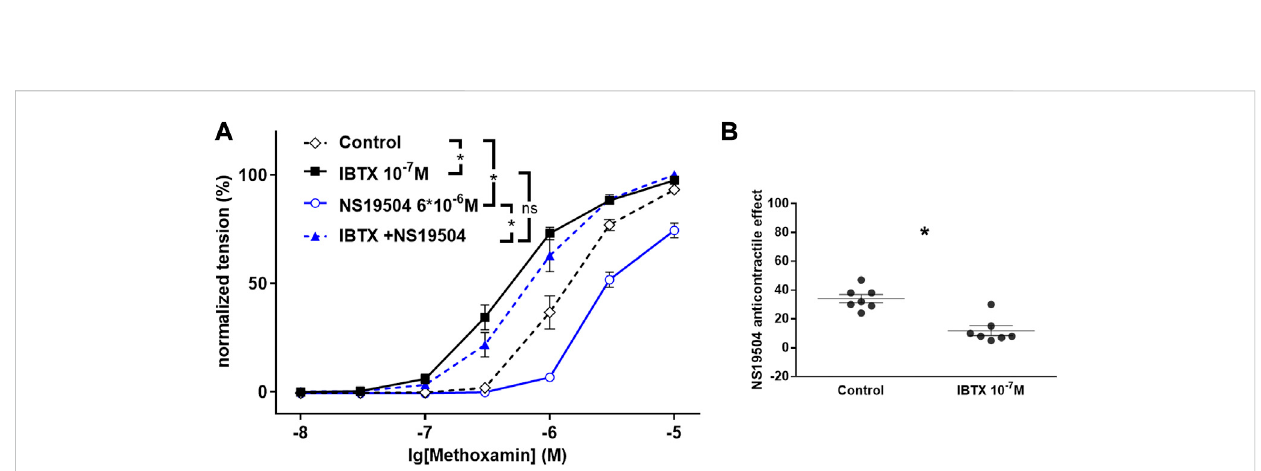
FIGURE 2 Effect of NS19504 and IBTX on methoxamine-induced contractions of the rat A. saphena. (A) Normalized tension (normalized to the maximum responseofthe1stCRR-seeFigure1)ofA.SaphenaatdifferentmethoxamineconcentrationsintheabsenceofBKchannelactive agents (Control), inthe presenceofIBTX(IBTX10 − 7 M),inthepresenceofNS19504(NS195046*10 − 6 M)andinthecombinedpresenceofNS19504andIBTX(NS19504andIBTX). (B) NS19504 anti-contractile effect in the absence (Control) and presence of IBTX (IBTX 10 − 7 M). N = 7; * - p < 0.05. Reproduced and modi fi ed with permission from (Ma et al.,